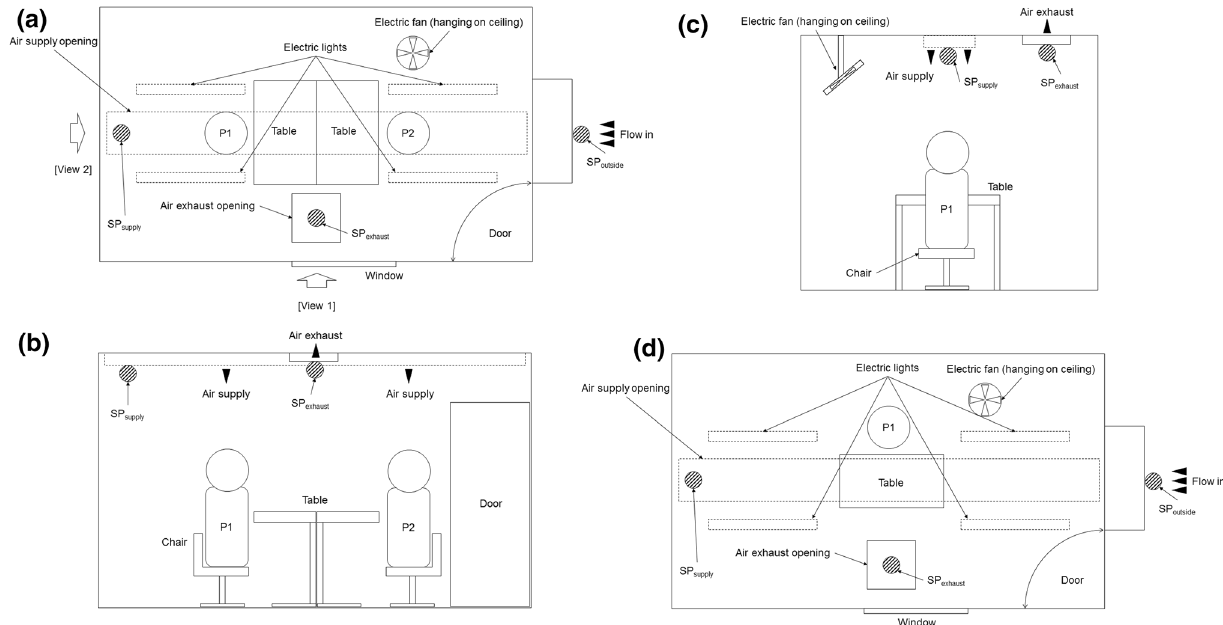
Fig. 2 Layout of environmentally controlled chamber: a Layout of “Restaurant” conditions (view from ceiling); b side view of “Restau- rant” conditions (view from [view 1] in a ); c side view of “Restaurant”